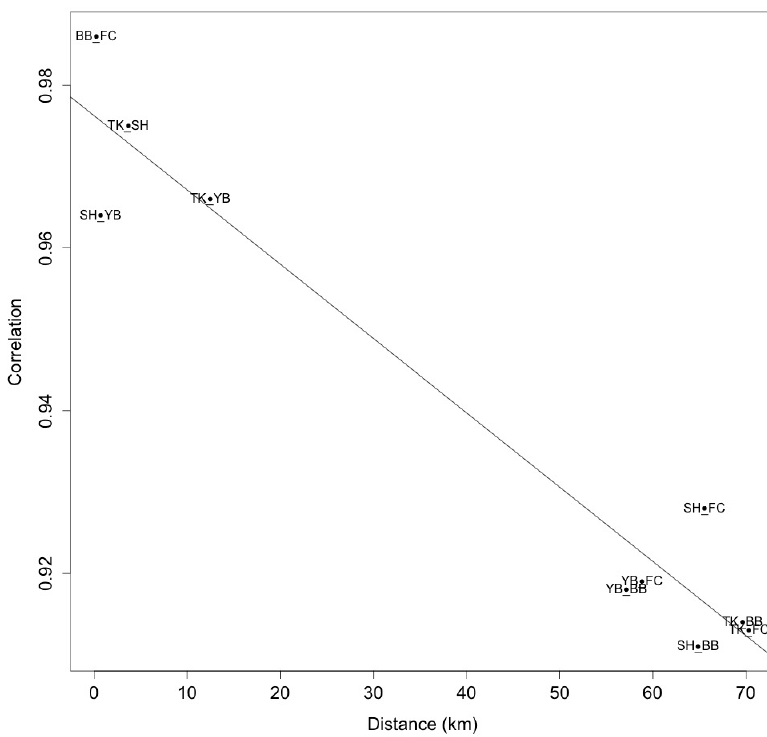
Figure 6. Relationship between the distance between study sites and logger temperature Pearson r correlation coefficient value. Closer study sites were more strongly correlated with each other than farther sites. The points are labeled with the abbreviation of each pair of study sites. Study sites shown are: Fogarty Creek (FC), Boiler Bay (BB), Strawberry Hill (SH), Tokatee Klootchman (TK), and Yachats Beach (YB). For example, SH_YB represents the relationship between the correlation strength of logger temperatures and the distance between Strawberry Hill and Yachats Beach.